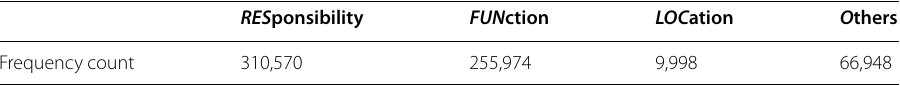
Table 3 Frequency count of named entities in